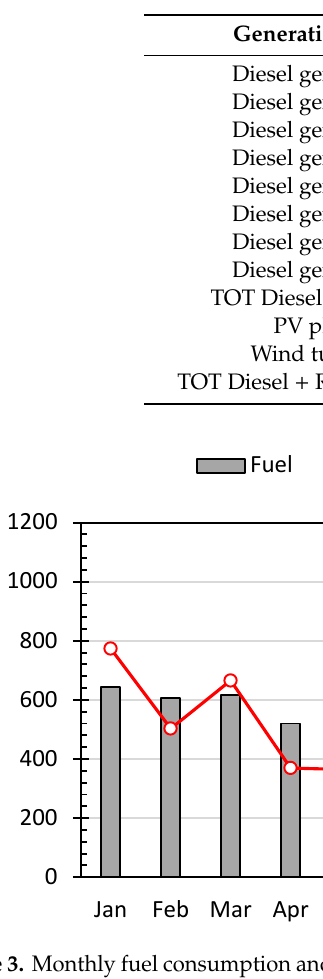
Figure 3. Monthly fuel consumption and average specific fuel consumption, data elaborated by authors taken from [80].